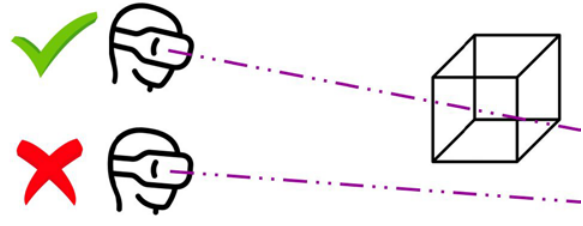
Figure 4: Graphic explanation of the orientation task.